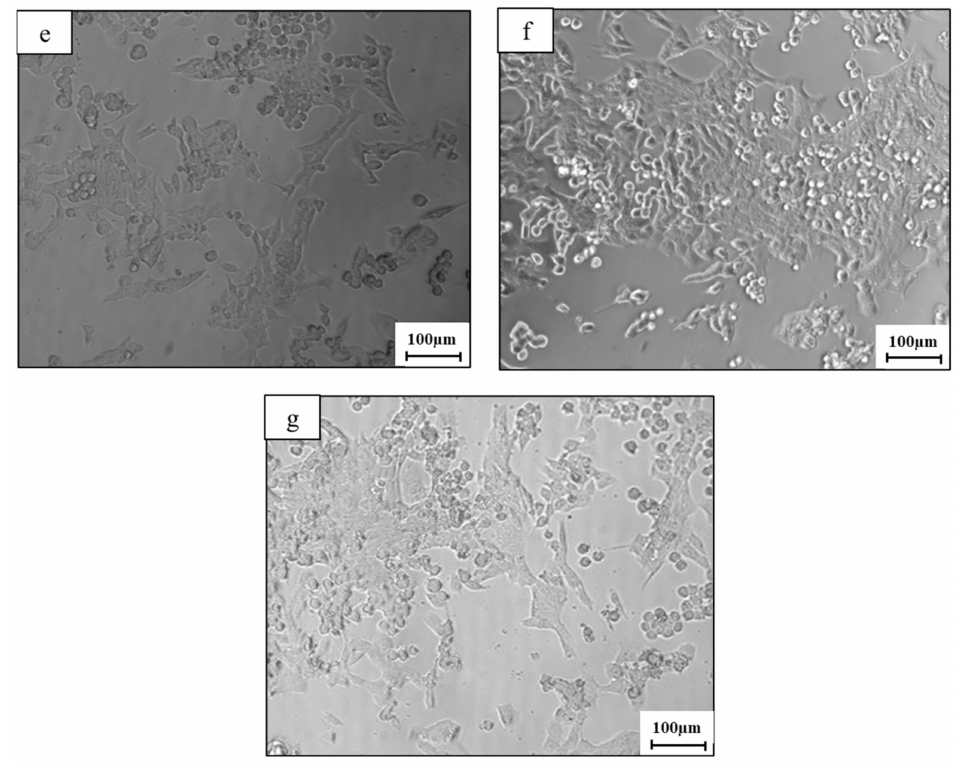
Figure 13. General view of 4T1 cells after 48h of incubation: ( a ) DMEM only; ( b ) DMEM+DMSO; ( c ) TI6Al4V; ( d ) Zn-2%Fe; ( e ) Zn-2%Fe-0.3%Mn; ( f ) Zn-2%Fe-0.6%Mn; ( g )